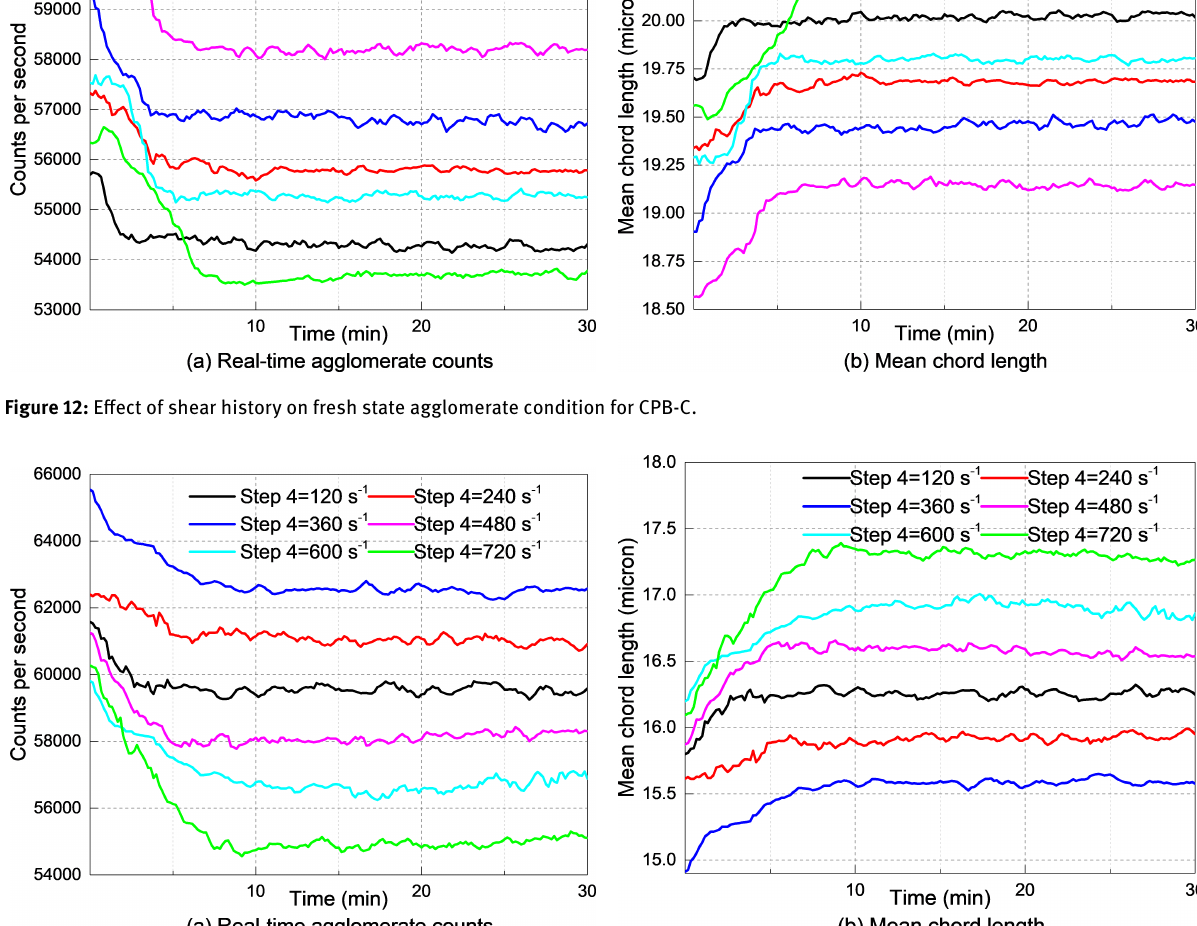
agglomeration rate of the CPB was calculated on the re- sults of FBRM tests at the agglomeration period, shown in Figure